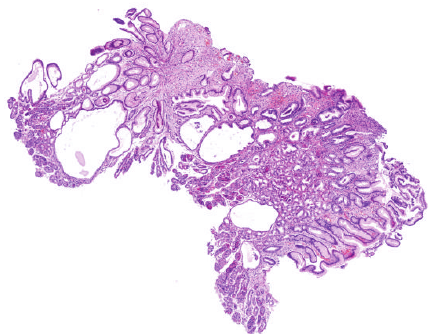
Figure 5: Juvenile polyp of gastric mucosa. Foveolar hyperplasia and dilation of glands are evident (hematoxylin-eosin, original magnification